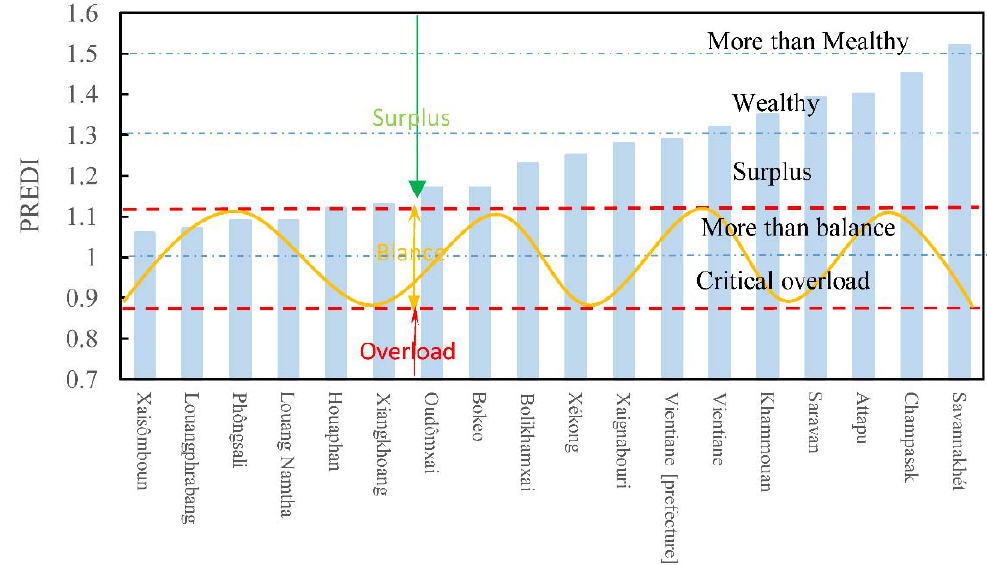
Figure 9. Grading of RECCI of resources and environment by province in Laos.